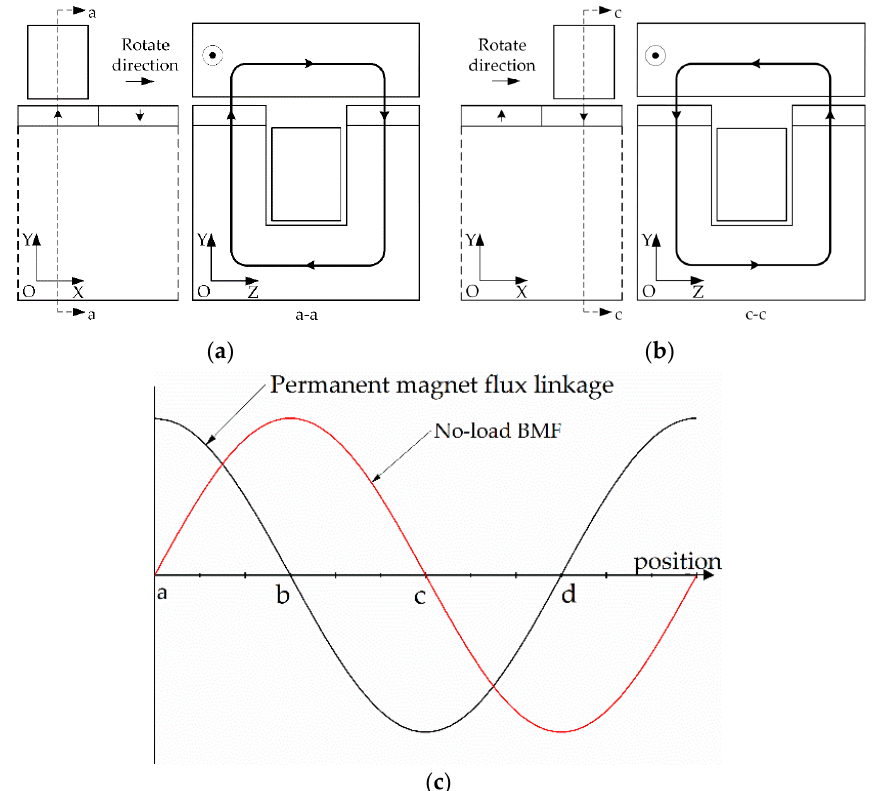
Figure 2. The permanent magnet flux path and induction principle of no ‐ load BMF for CS ‐ TFM: ( a